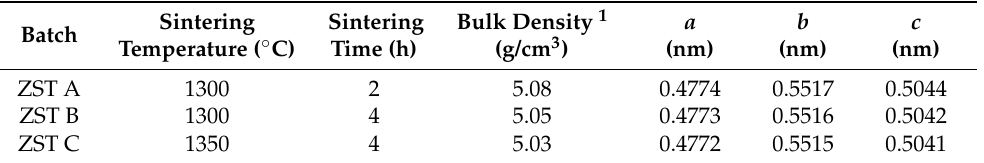
Table 1. The bulk density and lattice constants of Zr 0.8 Sn 0.2 TiO 4 (ZST) ceramics for different sintering